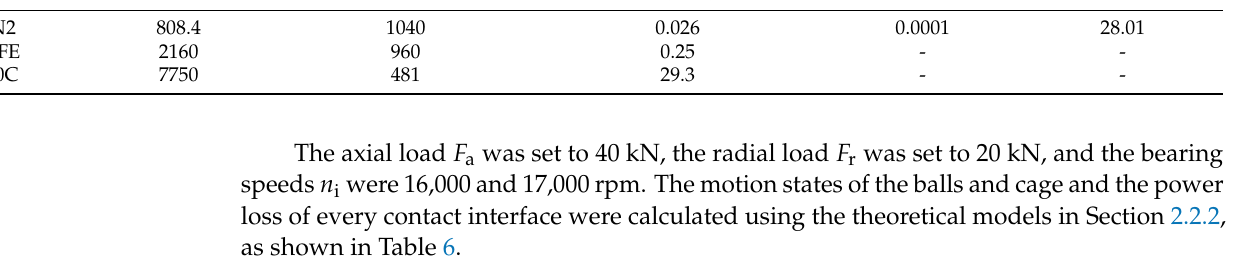
Table 6. Bearing motion boundary condition and power loss for one